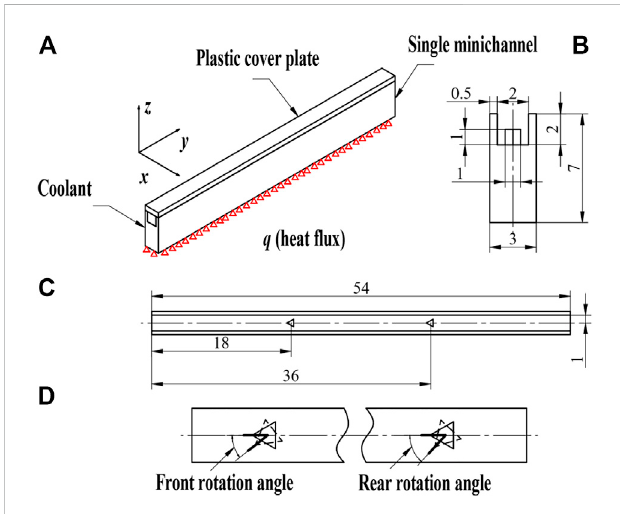
FIGURE 1 The geometry of minichannel: (A) 3D model; (B) cross-section of minichannel; (C) thearrangementoftwotriangularpin- fi ns; (D) thefront rotation angle and rear rotation angle of the pin- fi